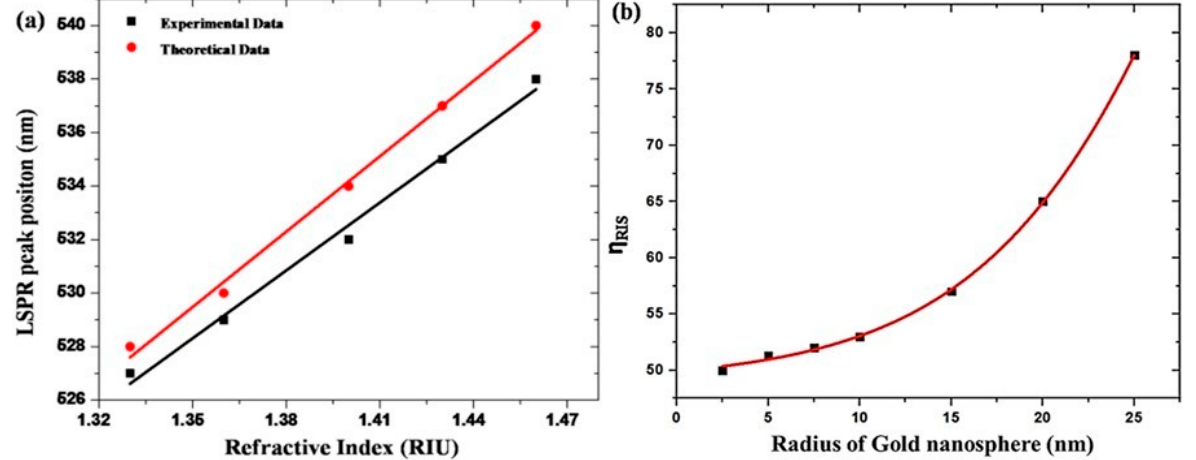
Figure 4. The LSPR peak position upon the change in refractive index of the surrounding solvents for gold nanospheres of radius 25 nm ( a ), and refractive index sensitivity as a function of radius for spherical NPs ( b ).